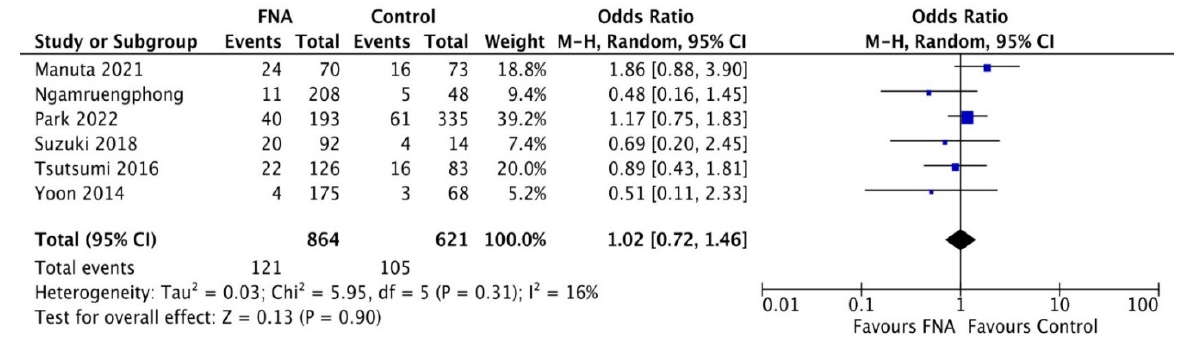
Figure 4. Forest plot comparing EUS-guided tissue acquisition versus non-sampling in terms of metachronous peritoneal dissemination. No difference in terms of metachronous peritoneal dissem- ination was observed between the two groups (OR 1.02, 0.72–1.46; p = 0.31), with evidence of low heterogeneity (I 2 =